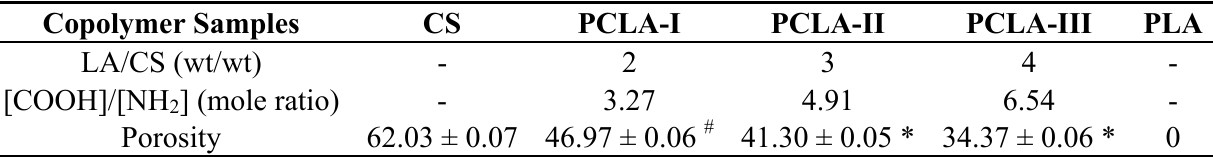
Table 1. Basic parameters of copolymers (mean ± SD, n =